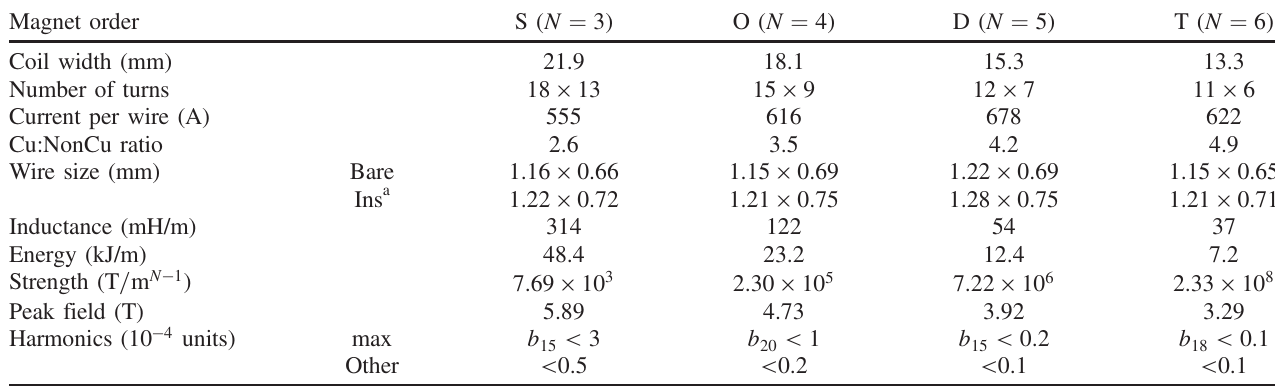
TABLE I. Optimal parameters obtained with DASH for cosine-theta magnets without iron poles ranging from sextupole to dodecapole. The number of turns and wire size are expressed as “ radial × azimuthal ” . Harmonics are expressed at reference radius r 0 ¼ 17